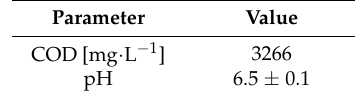
Table 1. Parameters of wastewater applied for